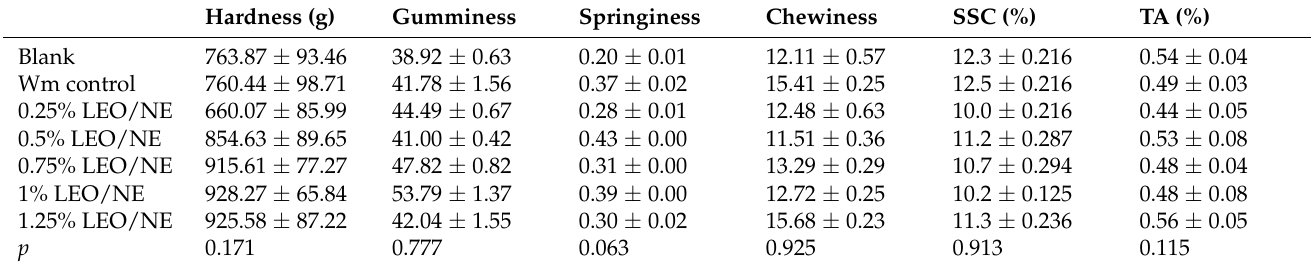
Table 2. The hardness, Gumminess, Springiness, Chewiness, soluble solids, and titratable acid of kiwifruit treated by